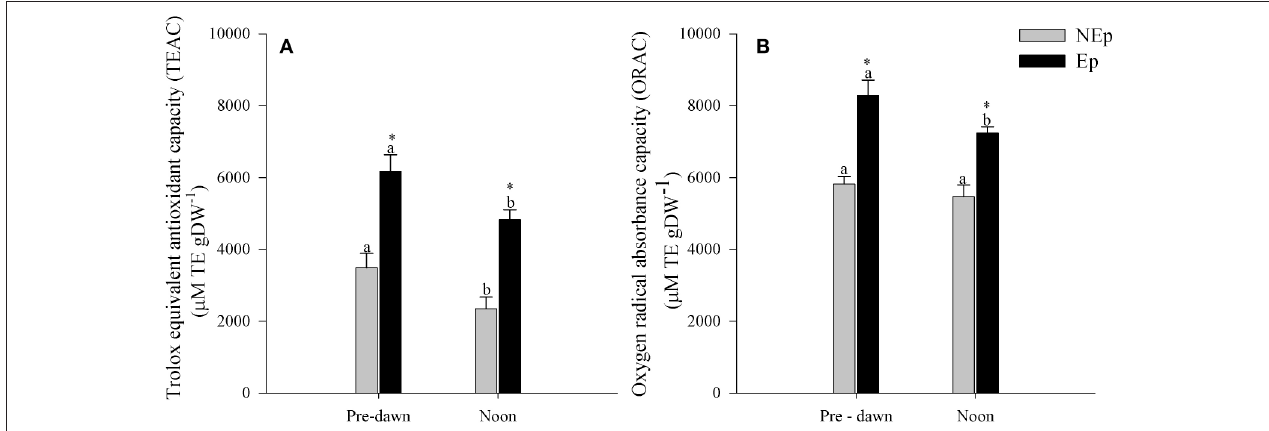
FIGURE 5 | Antioxidant capacity (TEAC) (A) and oxygen radical absorbance capacity (ORAC) (B) in Posidonia oceanica leaves with (Ep) and without (NEp) epiphytes, at pre-dawn and noon. Different letters indicate significant differences between pre-dawn and noon; * indicates significant differences between Ep and NEp leaves ( n = 5 , p < 0.05 ).